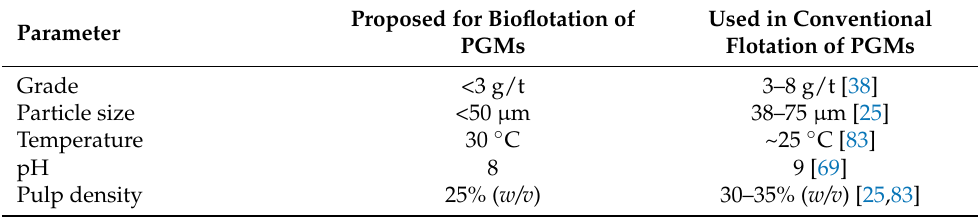
Table 7. Proposed parameters for PGM bioflotation and those used in conventional PGM